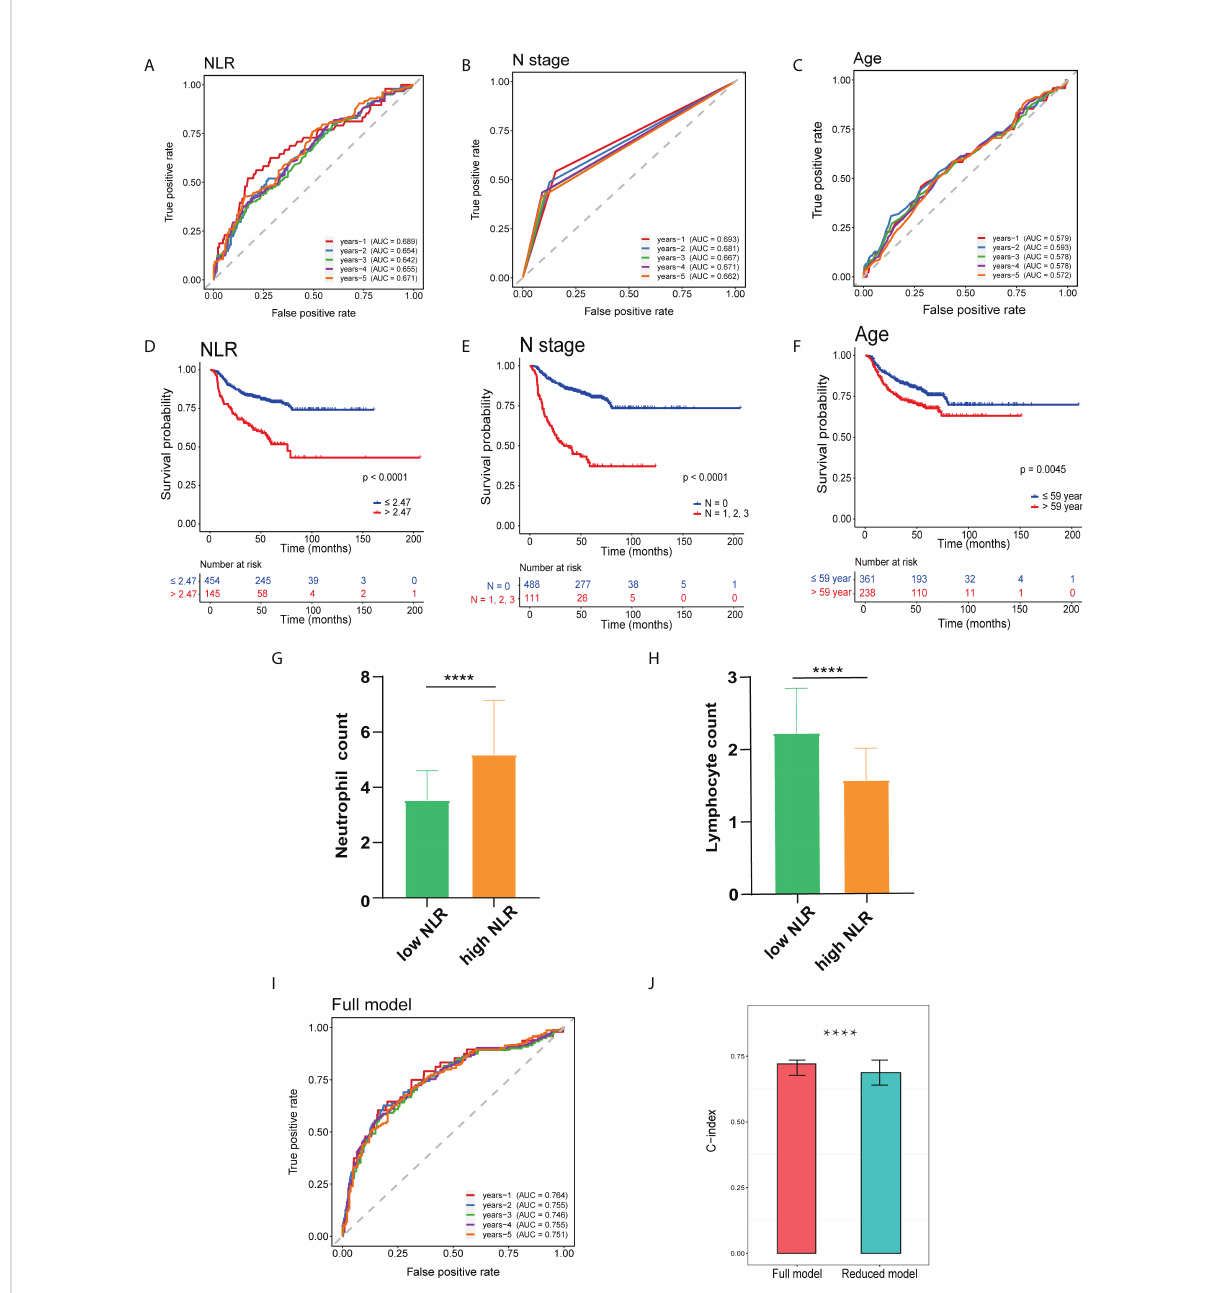
FIGURE 2 Prognostic analysis of HNSCC independent risk factors. (A – C) Receiver operating characteristic (ROC) curve of patients ’ preoperative peripheral neutrophil-to-lymphocyte ratio (pNLR) (A) , pathology N stage (B) , and age (C) on OS at 1 – 5-year follow-up. (D – F) Kaplan – Meier overall survival (OS) curves of patients ’ preoperative pNLR (D) , pathology N stage (E) , and age (F) . (G, H) Peripheral neutrophil (G) and lymphocyte (H) count in high- and low-pNLR groups. (I) ROC curves of the full model (including pNLR, age, and pathology N stage) on OS at 1 – 5-year follow-up. (J) C- index of full and reduced models. ****p ≤